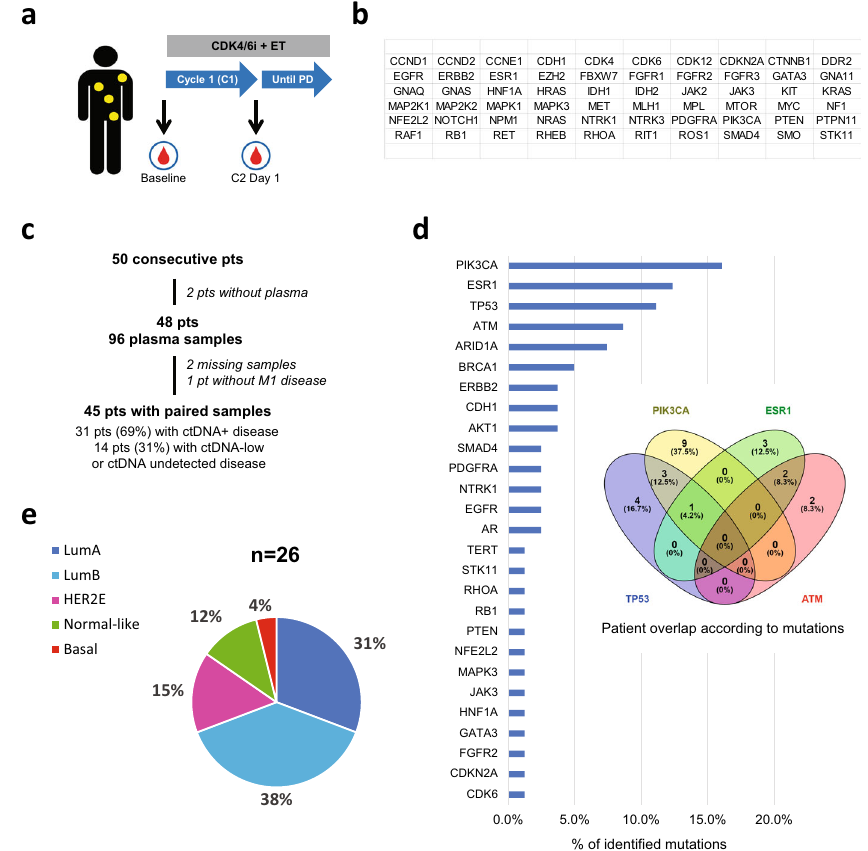
Fig. 1 Description of the study. a Blood samples were extracted at baseline and after 1 cycle (i.e. 4 weeks) in patients with metastatic HR + /HER2-negative BC treated with CDK4/6i plus ET. b The list of 74 genes analyzed by Guardant360. c CONSORT diagram. d Frequency of gene mutations with ≥ VAF 0.4% at baseline identi fi ed in the patient dataset and Venn diagram with the 4 most frequent mutations. e PAM50 distribution (LumA = Luminal A, LumB = Luminal B, HER2E = HER2-enriched). *PD Progressive disease, pts patients, M1